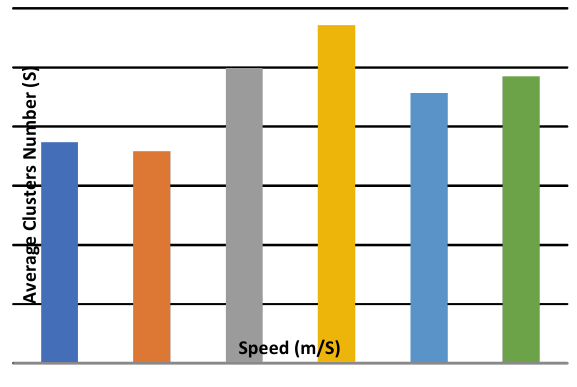
Fig. 4. The number of formed clusters.